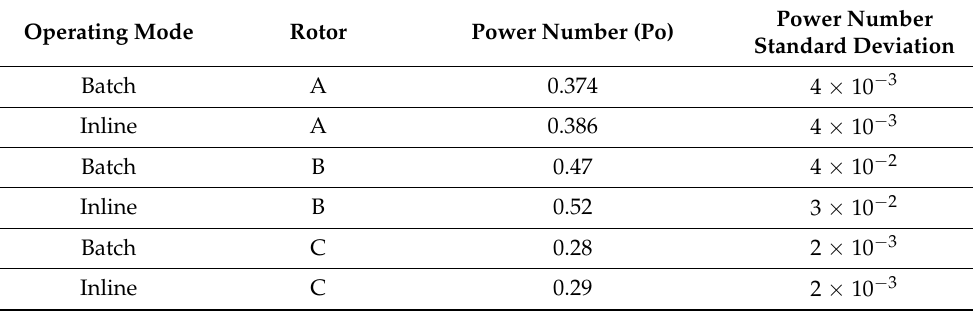
Table 5. Comparison of predicted power number for the different rotors operating in batch and inline modes with rotor speed 1000